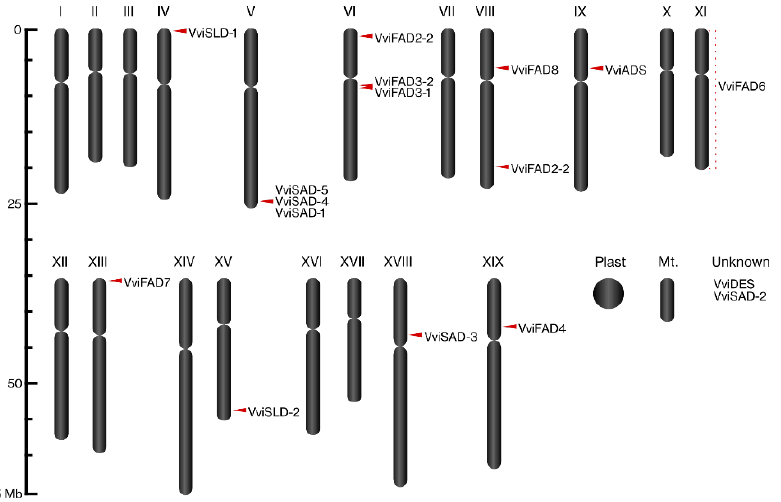
Figure 1. Chromosomal location of Vitis vinifera FA desaturases genes. The proposed nomenclature of each V. vinifera FA desaturase is shown for each chromosome.